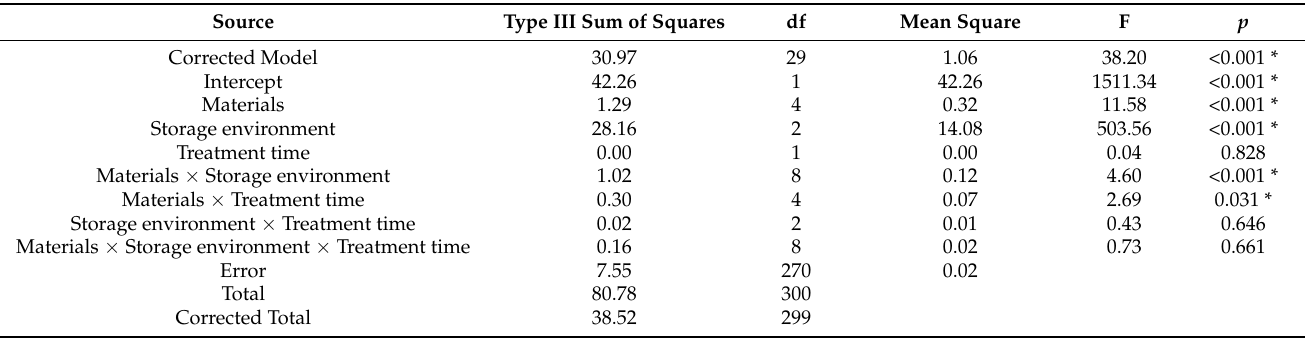
Table 2. Three-way ANOVA for the effect of independent factors and their interaction on sur- face roughness.